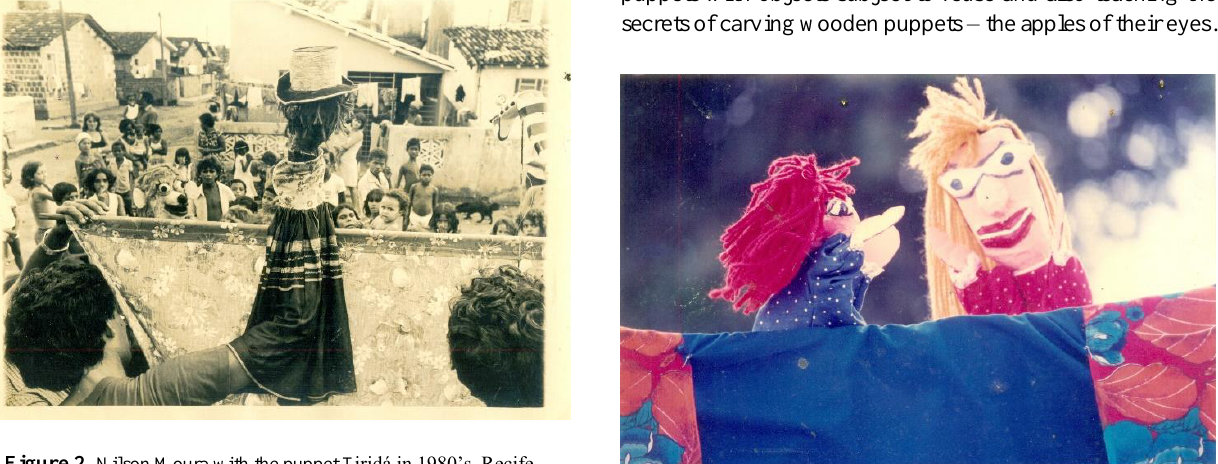
Figure 2. Nilson Moura with the puppet Tiridá in 1980’s, Recife.